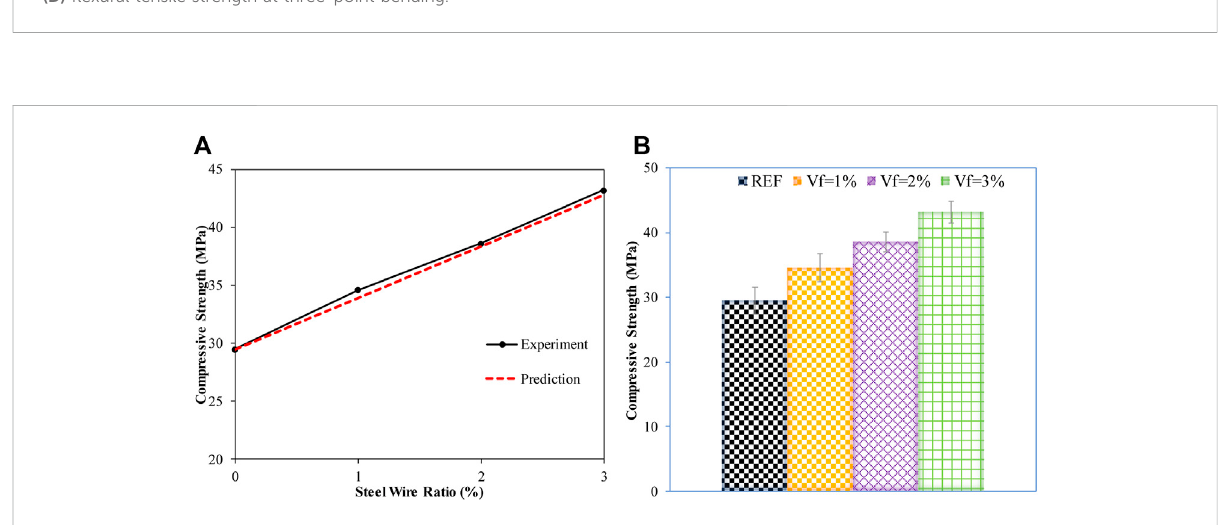
FIGURE 4 Results (A) of compressive (B)